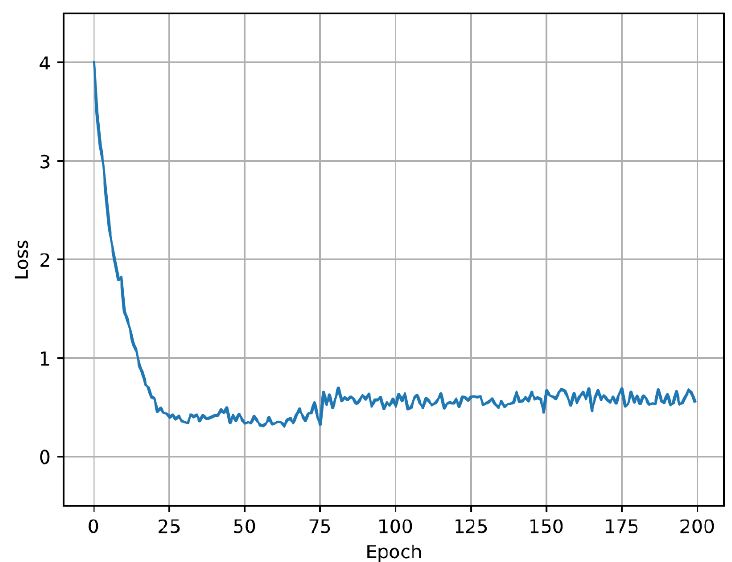
Figure 12. Loss of the Seq2Seq model during the training phase.